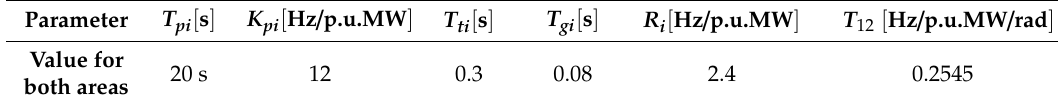
Table 1. The parameters of both control areas in power systems.